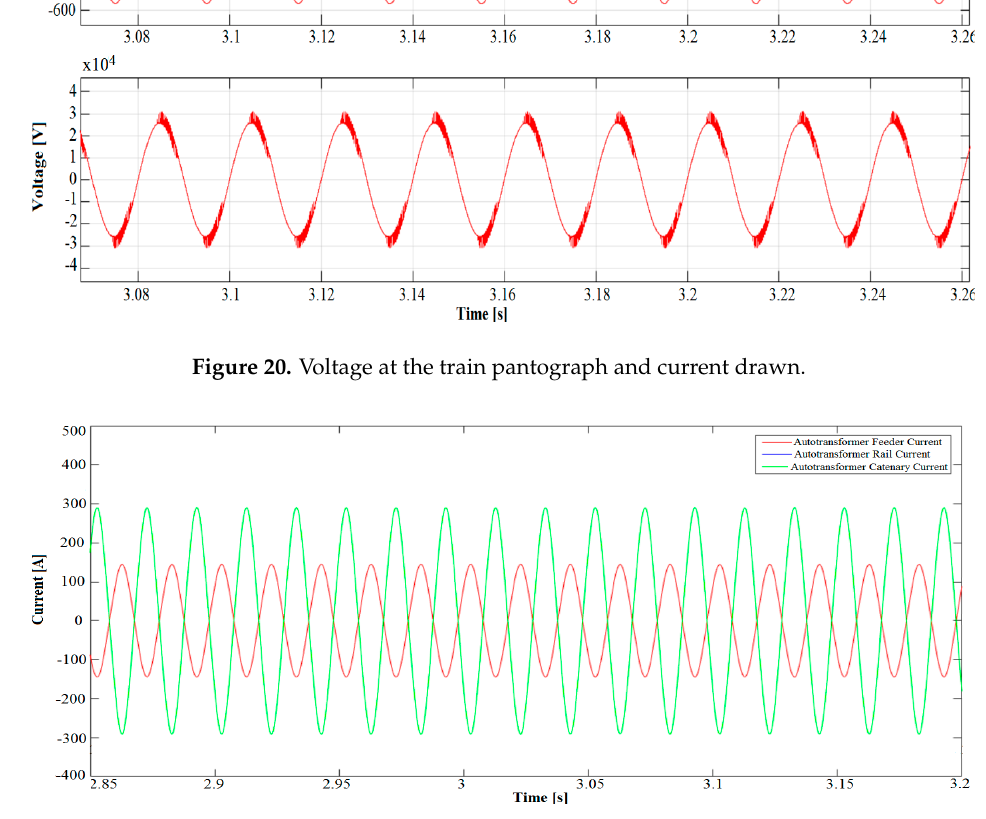
Figure 21. Current drawn by the autotransformer in the two-train scenario.